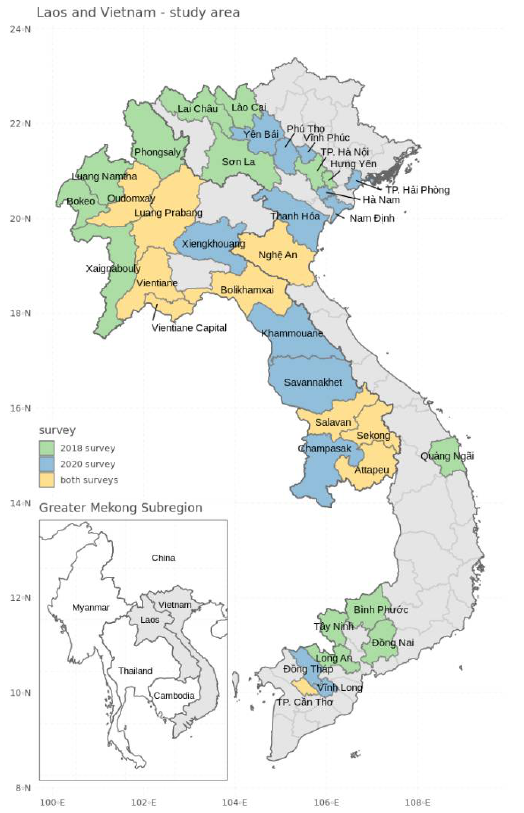
Figure 1. Laos and Vietnam survey area. Provinces that were surveyed in 2018 are indicated in green, and the provinces that were surveyed in 2020 are indicated in blue. The provinces that were surveyed during both years are indicated in yellow.